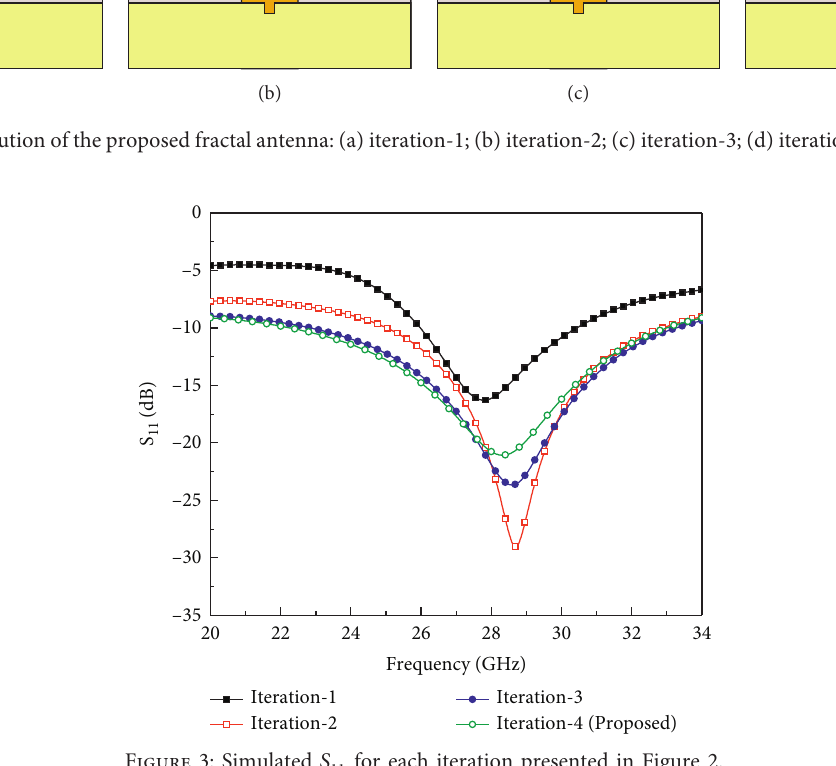
for each iteration presented in Figure 11